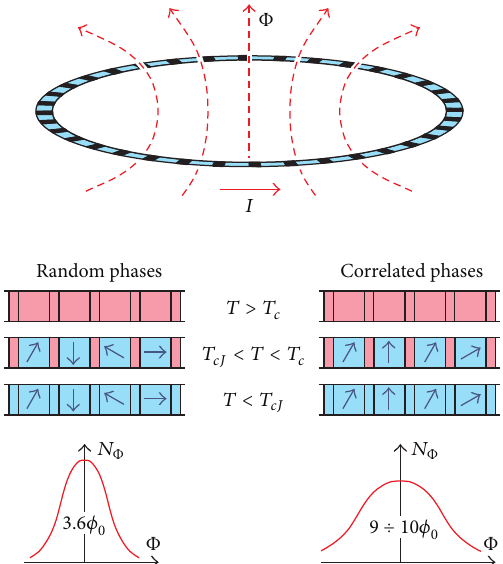
Figure 3: Basic design and principal results of the MJJL